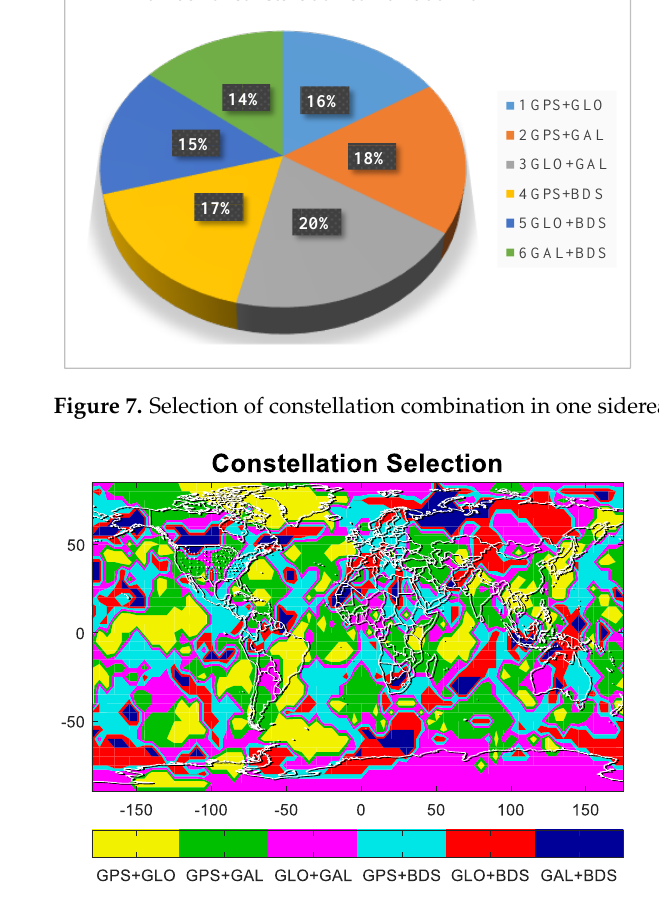
Figure 8. Worldwide distribution of constellation combination.